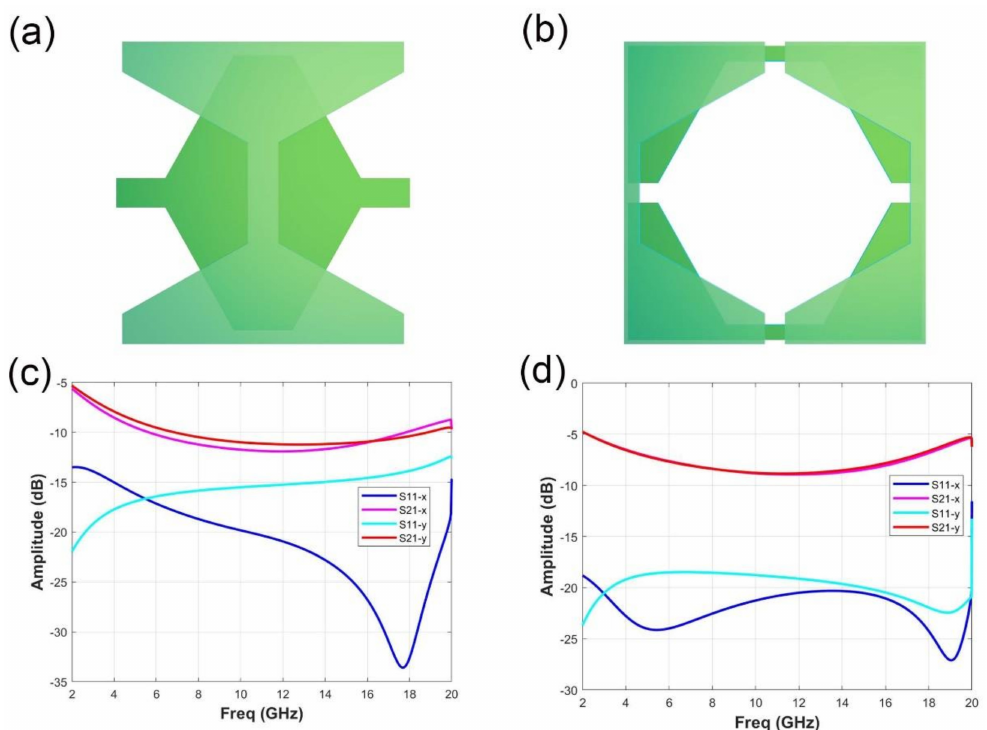
Figure 5. Simulation coe ffi cients of elements under di ff erent translation modes. ( a ) The view of the element when translated along the x axis for 1 / 2 period. ( b ) The view of the element after 1 / 2 period translation along x-axis and y-axis. ( c ) The simulation coe ffi cient after the element is translated along the x axis for 1 / 2 period. ( d ) Simulation coe ffi cient of the element after 1 / 2 period translation along x-axis and